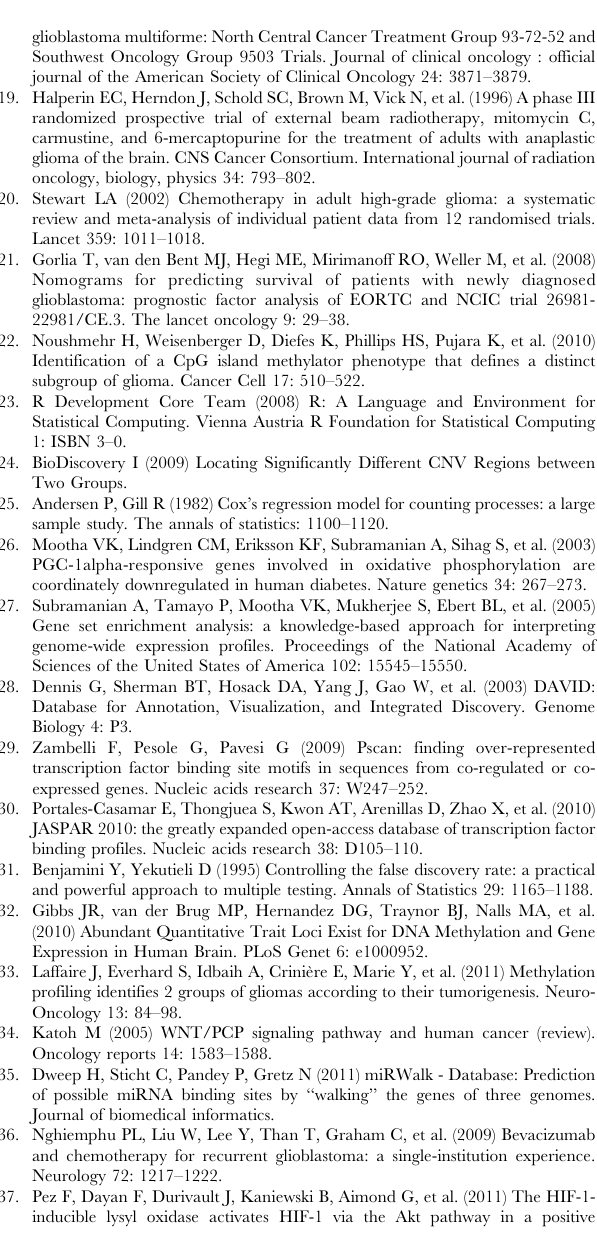
Table S15 GSEA results on old vs. young genes. NES: normalized enrichment score. Gene sets with negative (positive) enrichment scores are active in young (old) group.